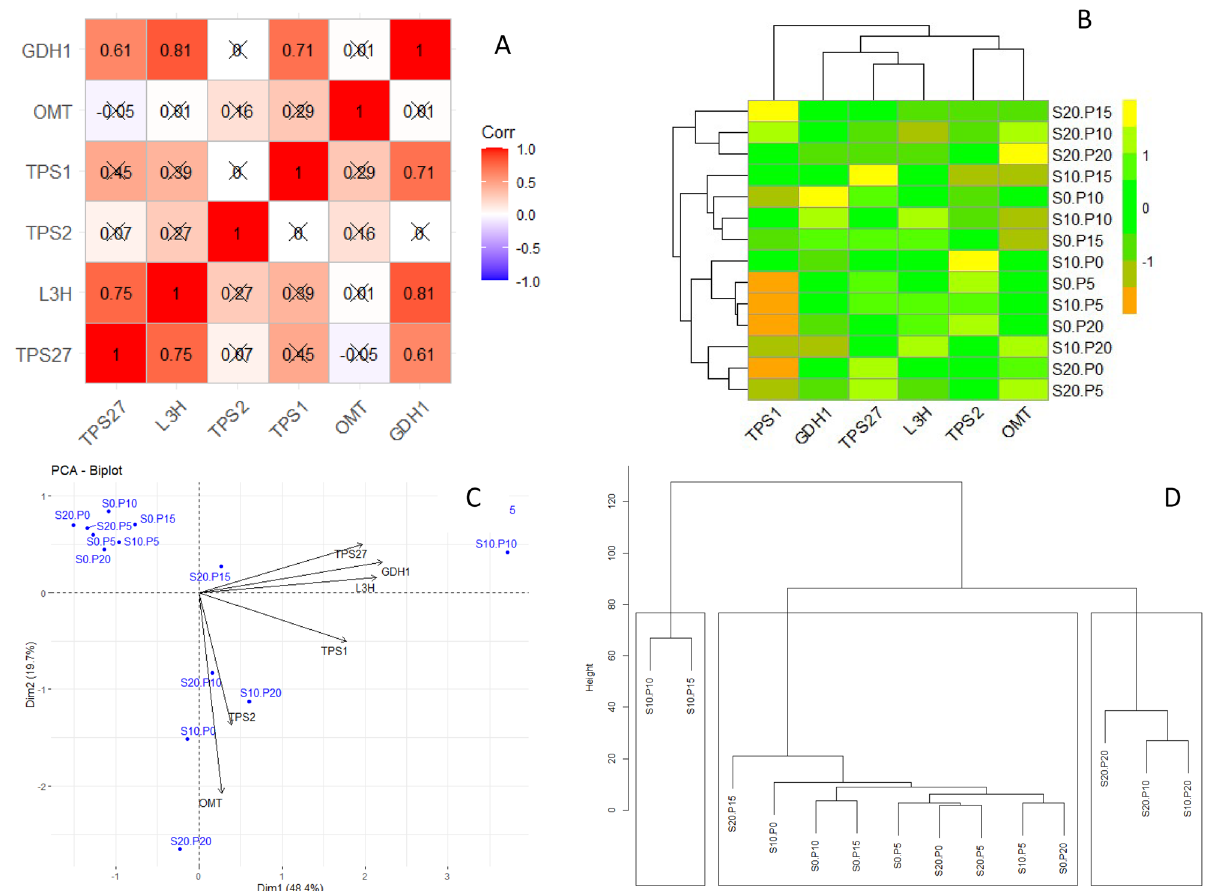
Figure 3. Correlation plot ( A ), heatmap ( B ), biplot ( C ), and clustering ( D ) of the expression profiling of essential oils genes in surahalala plant under PEG and Proline treatments. The analyses have been conducted on the average of the 8 replications in the experiment. S0_p0: 0% PEG and 0 µm proline; s0_p5: 0% PEG and µm proline; s0_p10: 0% PEG and 10 µm proline; s0_p15: 0% PEG and 15 µm proline; s0_p20: 0% PEG and 20 µm proline; s10_p0: 10% PEG and 0 µm proline; s10_p5: 10% PEG and 5 µm proline; s10_p10: 10% PEG and 10 µm proline; s10_p15: 10% PEG and 15 µm proline; s10_p20: 10% PEG and 20 µm proline; s20_p0: 20% PEG and 0 µm proline; s20_p10: 20% PEG and 10 µm proline; s20_p15: 20% PEG and 15 µm proline; s20_p20: 20% PEG and 20 µm